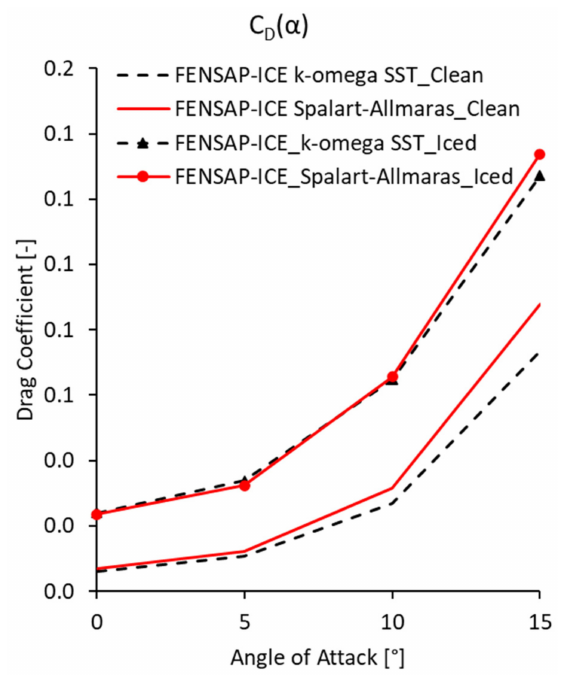
Figure 15. Drag coefficient (clean vs.